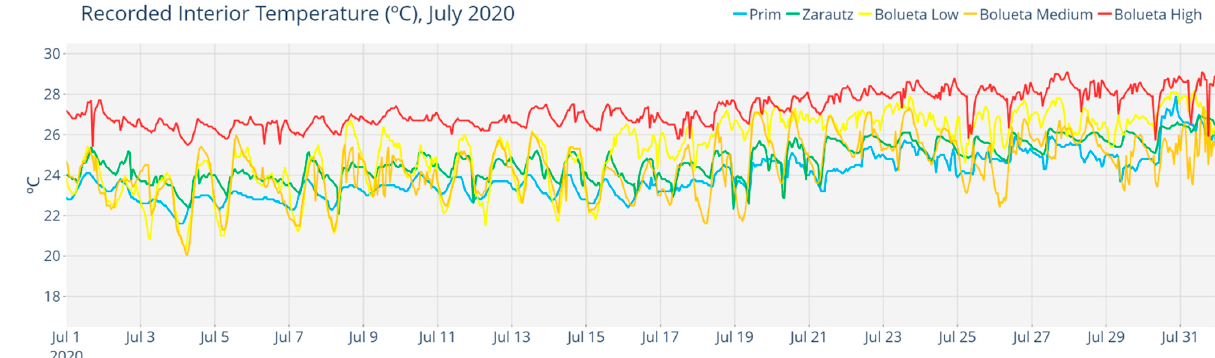
Figure 18. Recorded interior air temperature for all living rooms, July 2020. Source: authors.